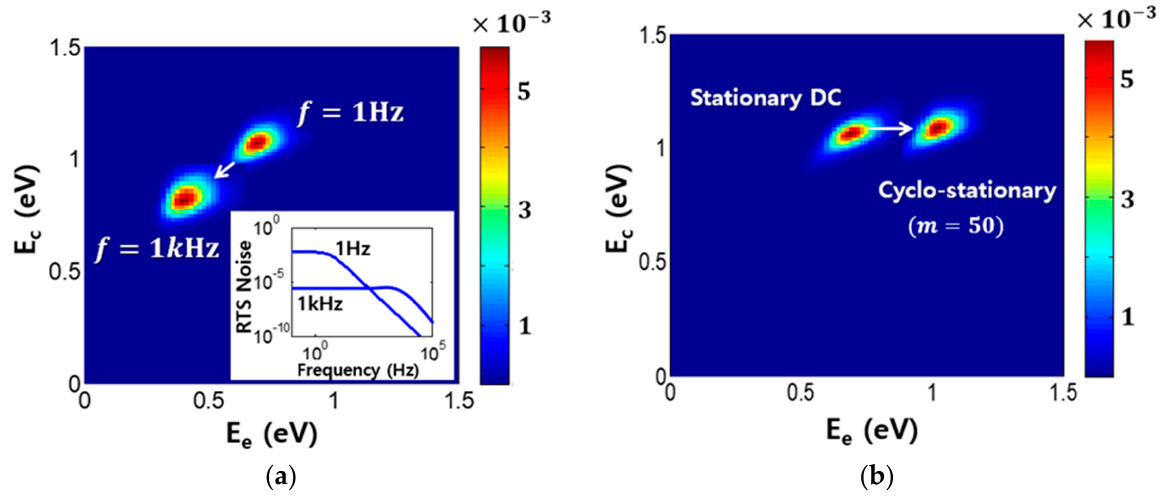
Figure 2. CEE map with fitted Gaussian mixture (GMM) using soft clustering. ( a ) Scatter plot of GMM data. ( b ) Comparison of GMM data with numerical data of CEE map.